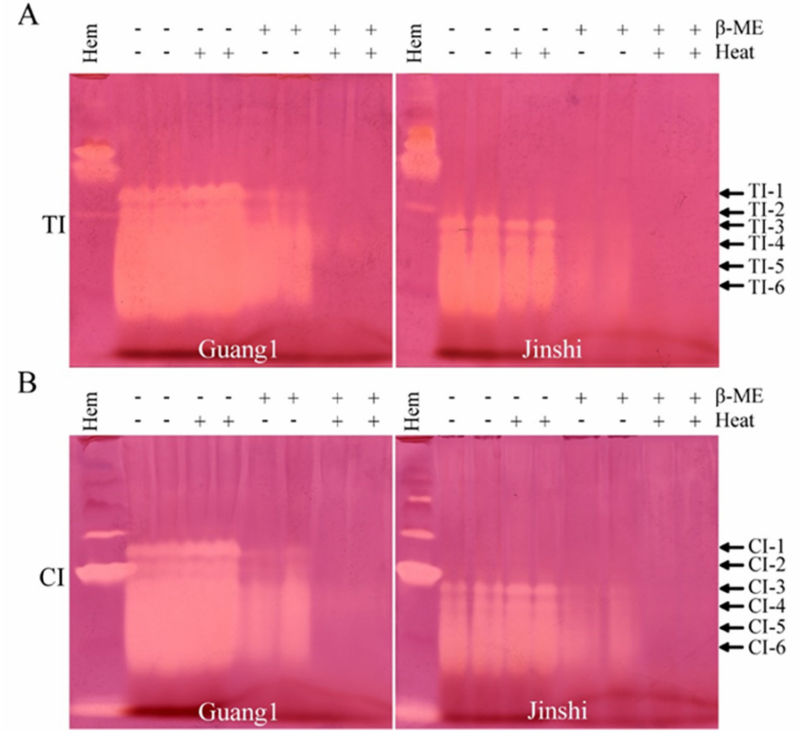
Figure 5. β -mercaptoethanol treatment could completely eliminate the activities of TIs and CIs from leaves of Guang1 and Jinshi. Activity staining of TIs ( A ) and CIs ( B ) from leaves of mulberry varieties Guang1 and Jinshi based on alkaline Native PAGE. “TI” and “CI” represent trypsin inhibitor and chymotrypsin inhibitor, respectively. B. mori hemolymph from day-5 fifth-instar larvae represented by “Hem” was used as positive control. “ β -ME” stands for reducing agent β -mercaptoethanol. “+” or “-” indicates with or without β -mercaptoethanol and heat treatment. The arrows show activity- stained bands of trypsin inhibitors and chymotrypsin inhibitors, which are named “TI-1~TI-6” and “CI-1~CI-6” from top to